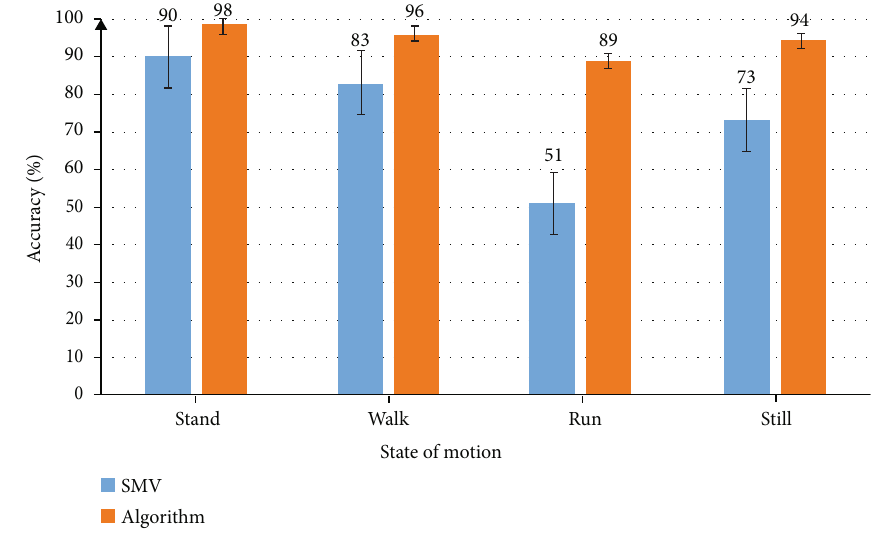
Figure 7: Analysis of posture monitoring